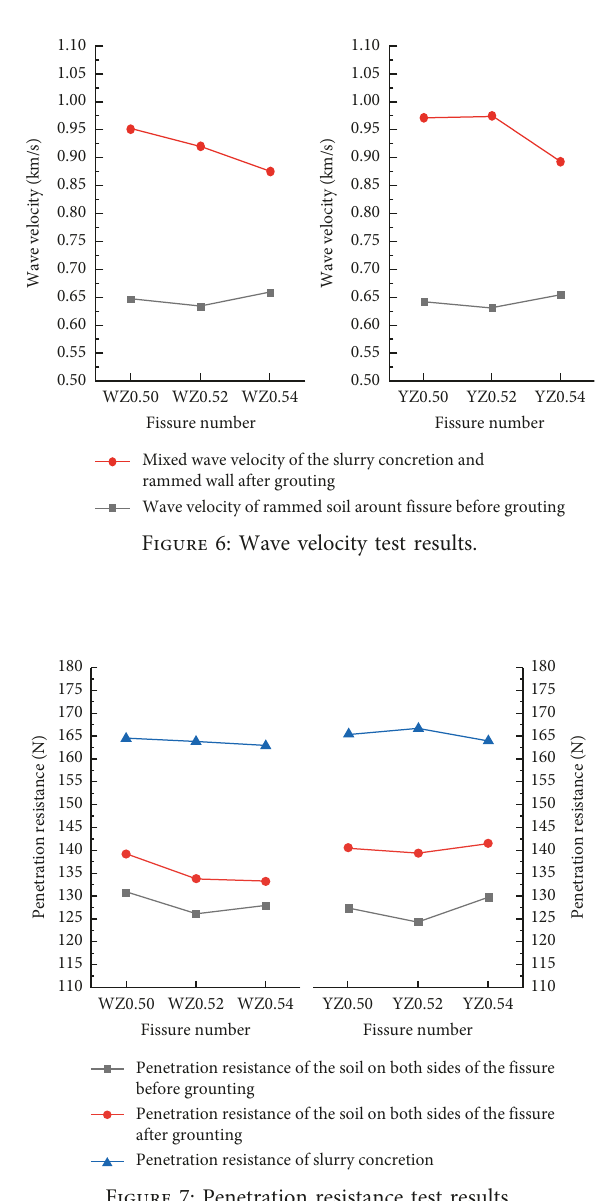
Figure 7: Penetration resistance test